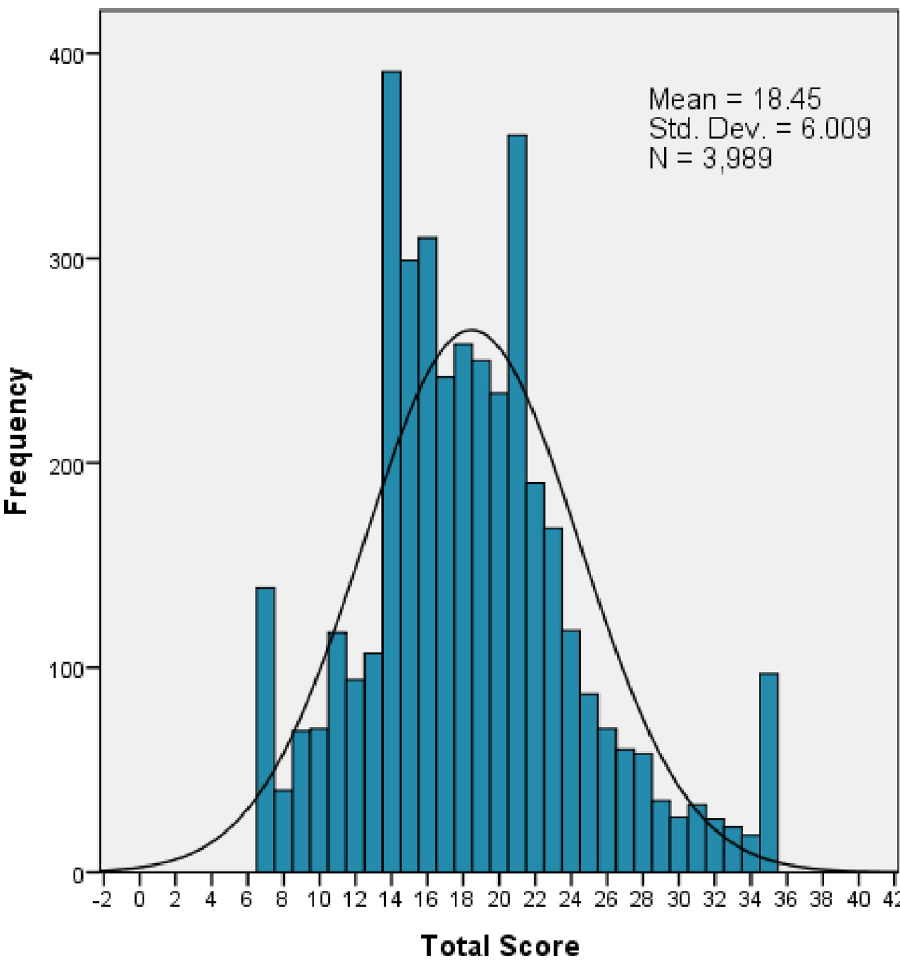
Fig 1. Participant’s FCV-19S score distribution.